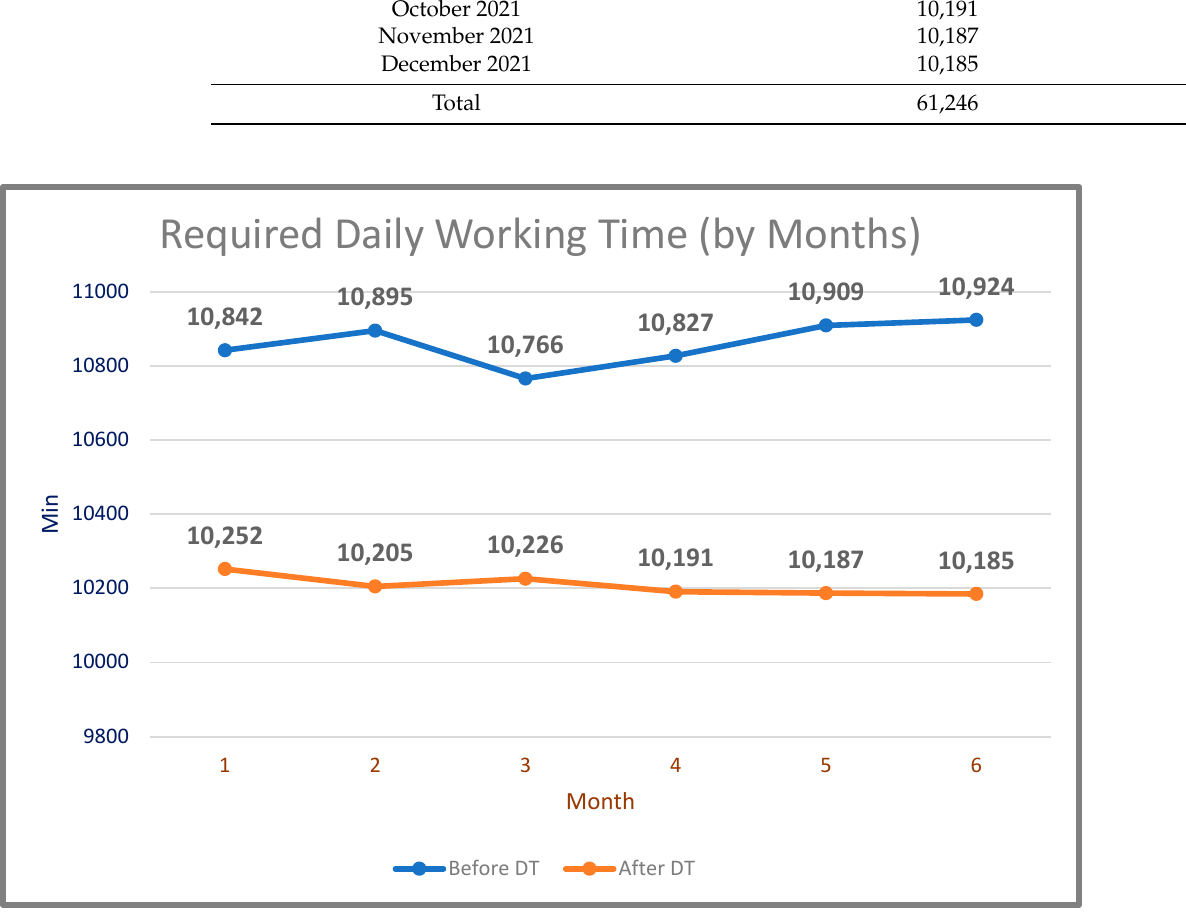
Figure 13. Minutes of daily working time required to do the same amount of work comparison by months (before and after DT).